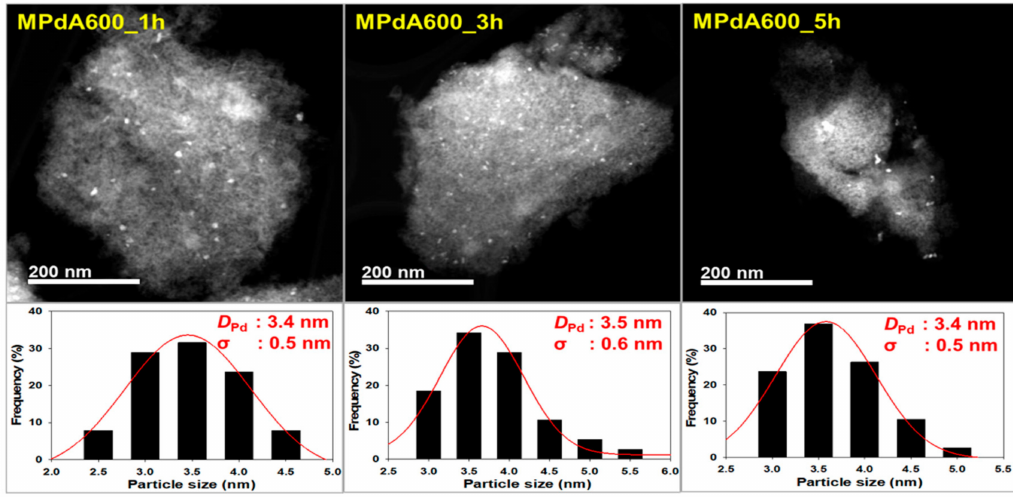
Figure 8. HAADF-STEM images and particle size distributions of the reduced MPdA catalysts calcined at 600 ◦ C for di ff erent durations ( D Pd : Pd mean size, σ : standard